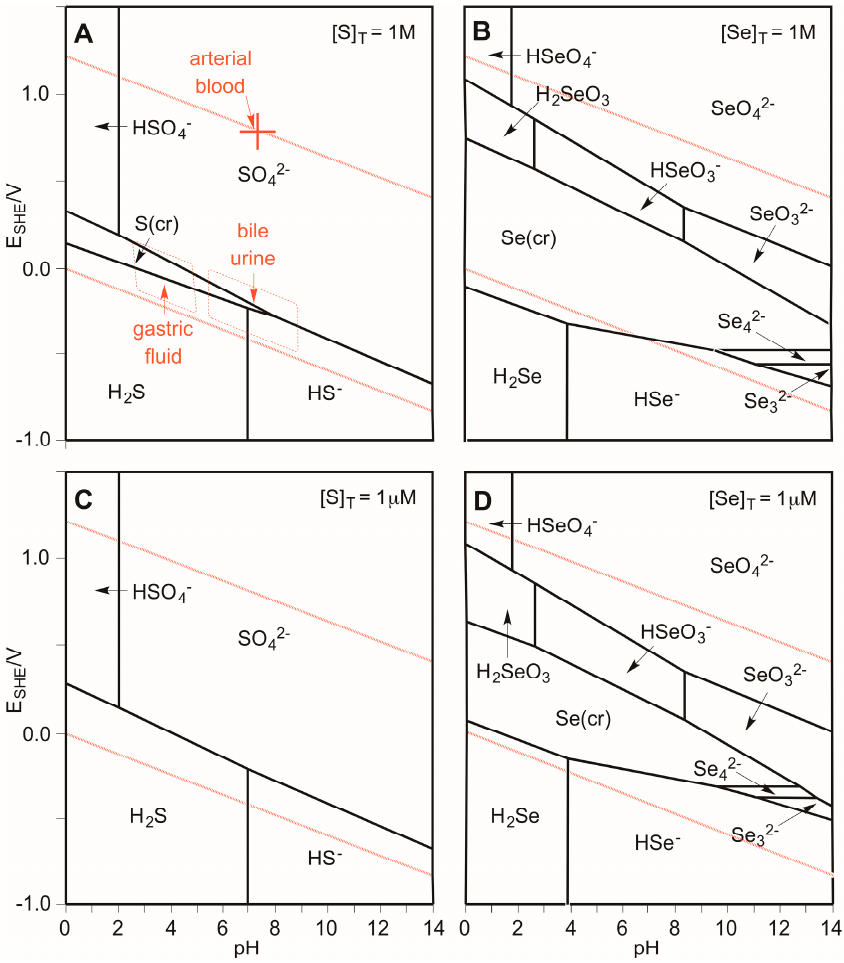
Figure 2. Pourbaix diagrams for S ( A , C ) and Se ( B , D ) at 1M total chalcogen ( A , B ) and 1 µ M total chalcogen ( C , D ) at 25 ◦ C. The red lines define the stability region of water. Various physiological fluids are illustrated ( A ) [55].